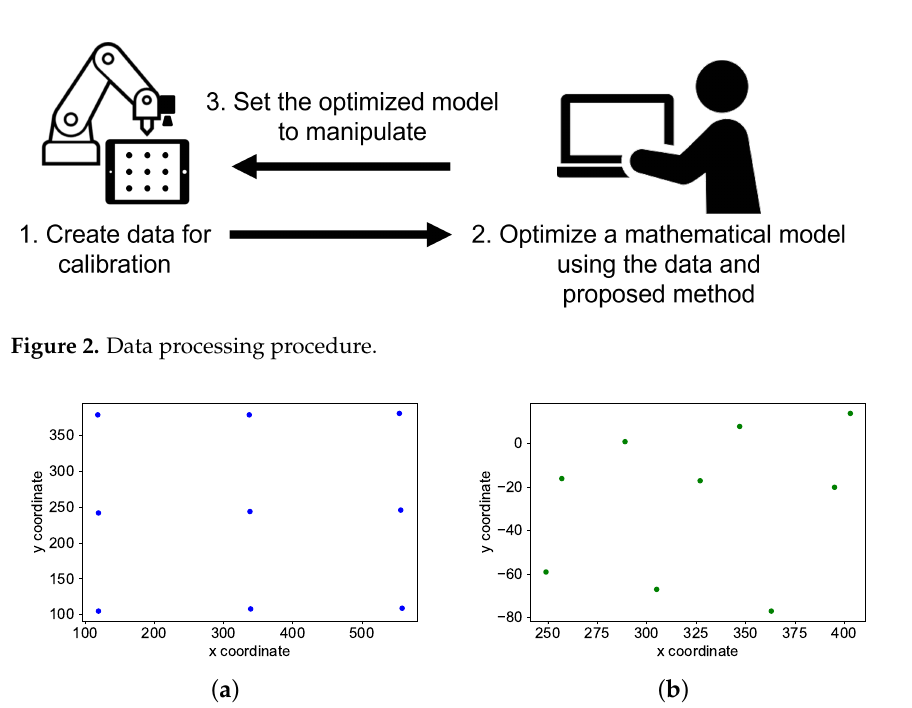
Figure 3. ( a ) Positions of landmarks in the image coordinate system; ( b ) positions of the hand in the robot-based coordinate Figure 3. (a) positions of landmarks in image coordinate system. (b) positions of hand in robot base coordinate system.